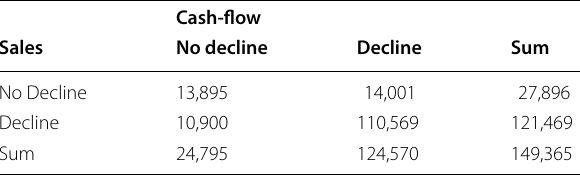
Table 1 Cross-tabulation of Sale and Cash-flow Decline in SSA. Source: authors construct based on WEBS follow-up survey